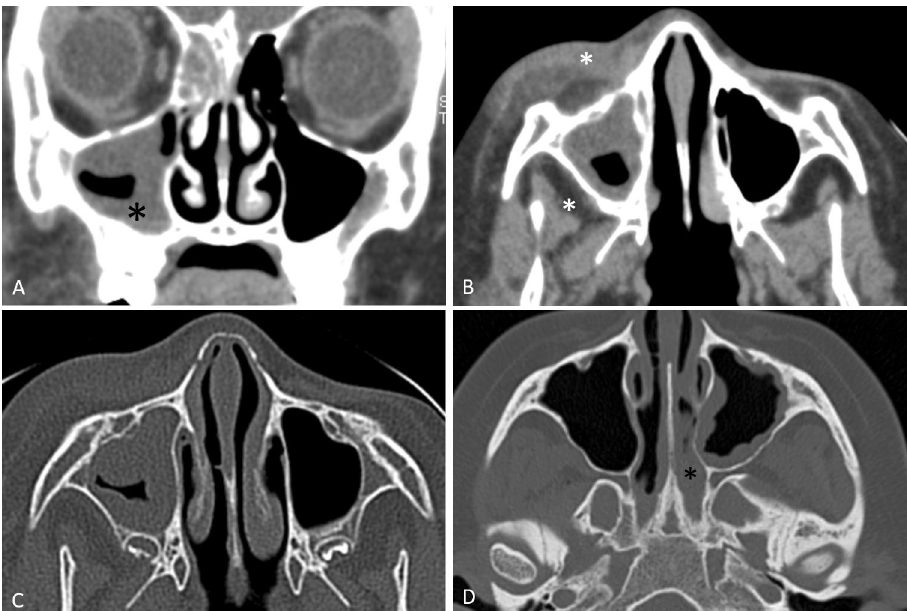
Figure 2. Examples of findings in patients with Aspergillus AIFR. ( A ) Coronal CT image shows unilateral mucosal thickening of the right maxillary sinus (asterisk) and the ethmoid air cells. ( B , C ) Axial images from the same patient shows fatty infiltration of the anterior periantral fat and the posterior periantral fat, without bony dehiscence. ( D ) Another patient with Aspergillus AIFR with unilateral mucosal thickening of the maxillary sinus and the nasal cavity